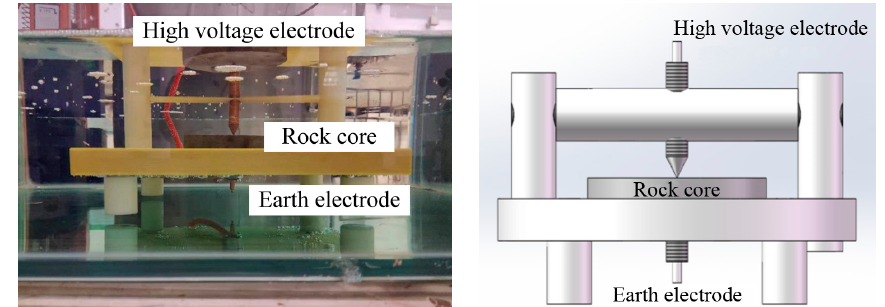
Figure 19. Schematic diagram of rock breakdown in transformer oil.